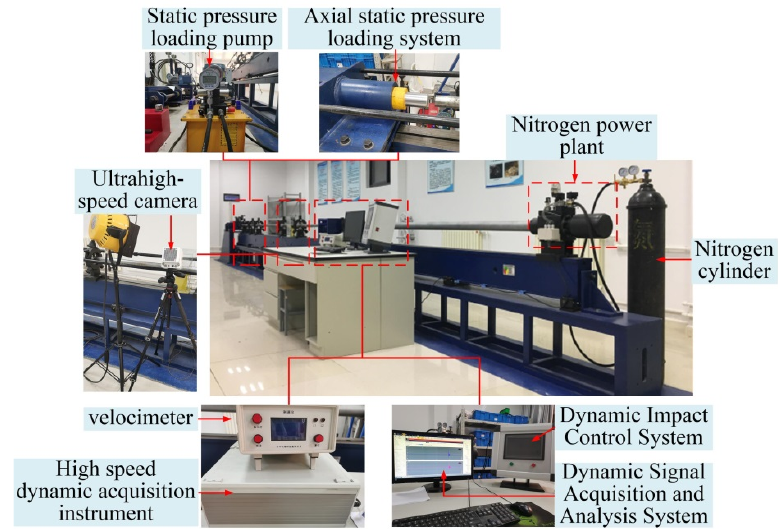
Figure 7. Separation Hopkinson pressure bar test system.